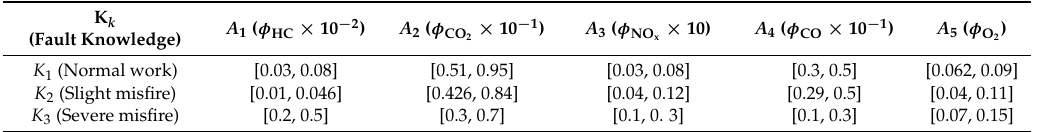
Table 1. Three kinds of fault forms for the engine EQ6102.